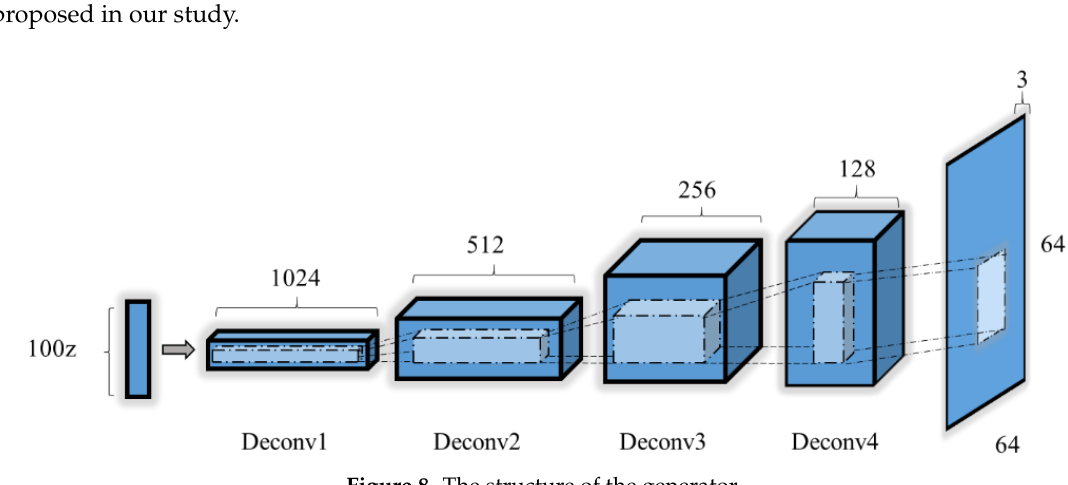
Table 2. Detailed architecture for the